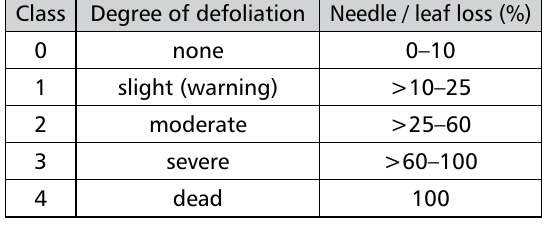
Classes of defoliation according to ICP Forests